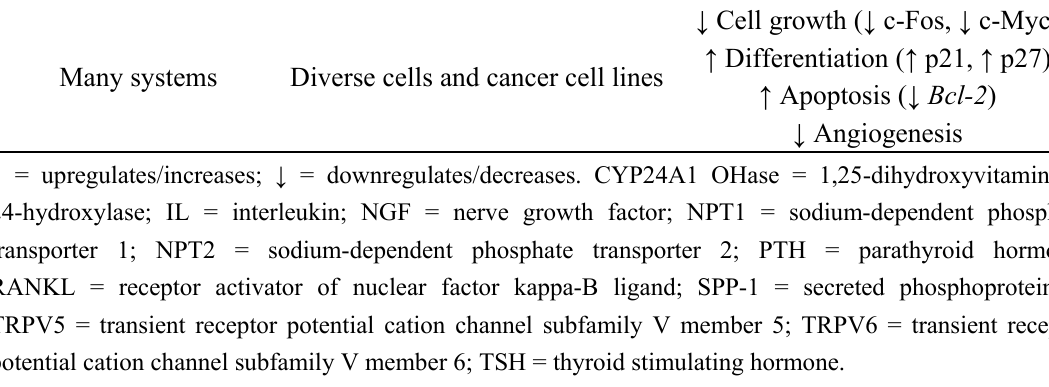
Figure 1. Ultraviolet radiation (290–330 nm) from the sun and body heat